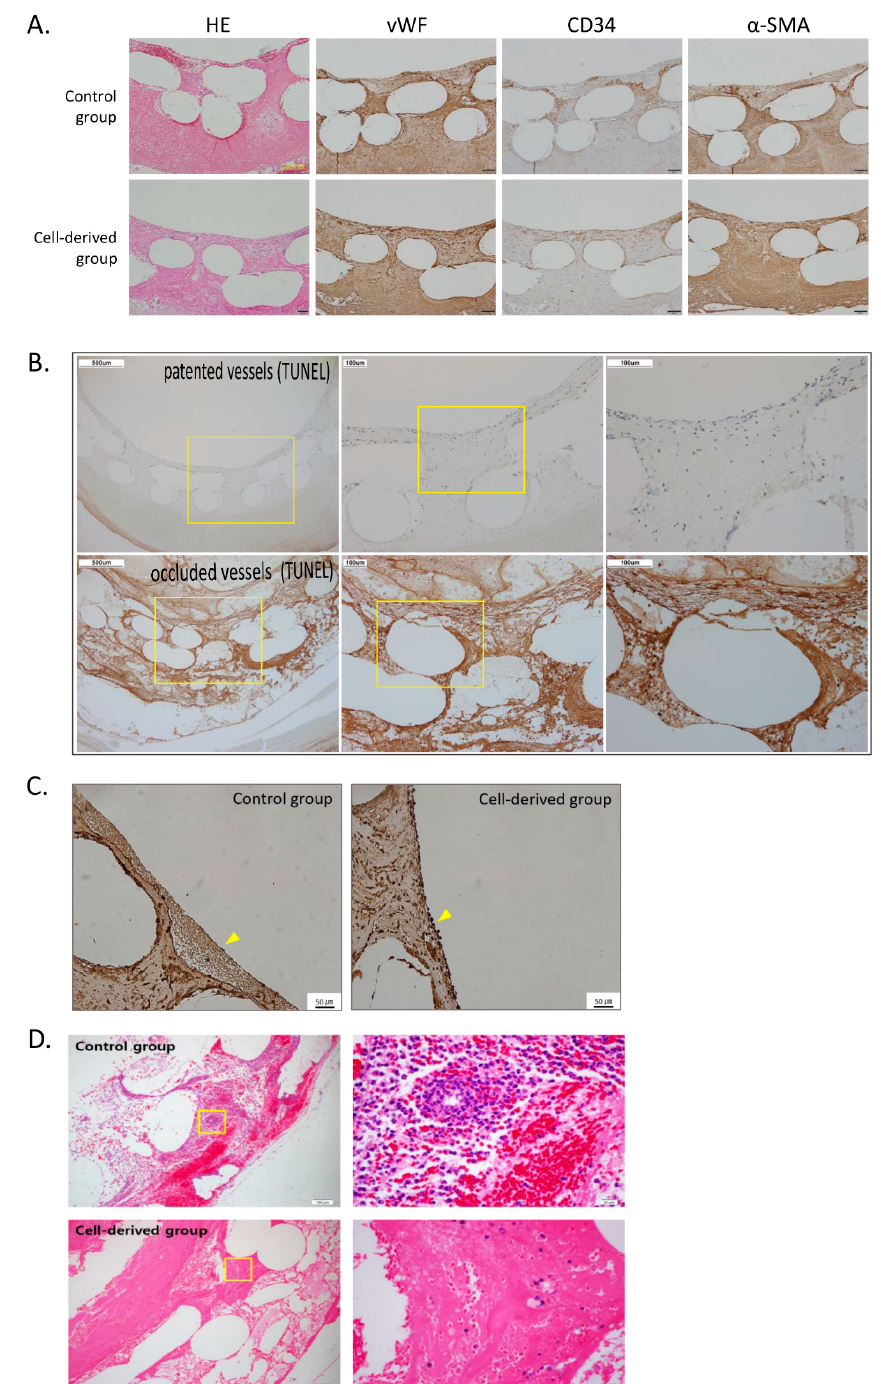
Figure 4. Pathology analysis of patented artificial vessels. ( A ) Implanted vessels were stained with H&E and IHC-P (vWF, CD34, α -SMA). Evaluated under an original magnification of X100 for photomicrography. ( B ) TUNEL staining between control group and cell-derived group. Evaulated under an original magnification of X40, X100, and X200. ( C ) Number of endothelial cells (ECs) was counted and comparatively analyzed on IHC-P (vWF) staining images using Image J software. Evaluated under an original magnification for photomicrography of x200. ( D ) The inflammation score was measured, and compared with the H&E staining image. Evaluated under an original magnification for photomicrography of X100,